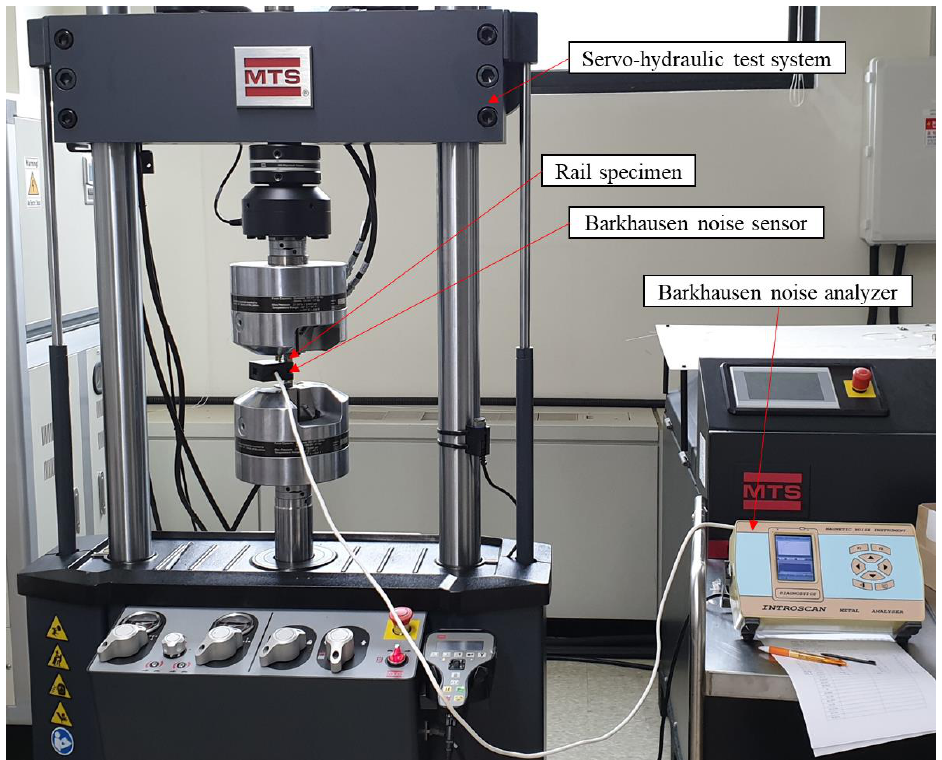
Figure 3. Photograph of the experimental setup for measuring stresses in rail specimens under tensile loads by the servo-hydraulic test system.